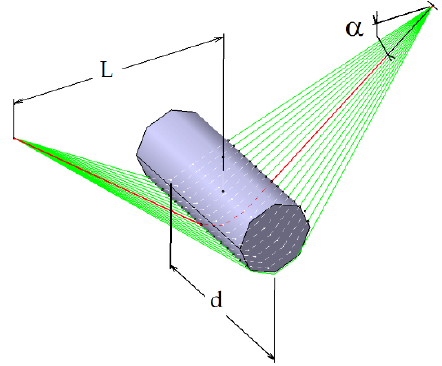
Figure 3. Fibre bundle spreading model.